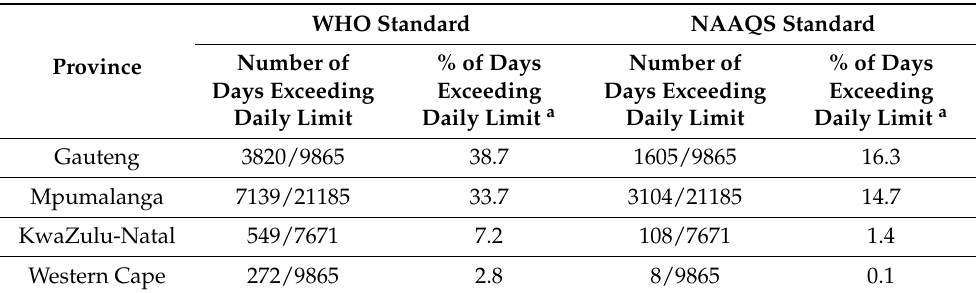
Table 3. The percentage of PM 10 ( µ g/m 3 ) concentration exceeding daily standards by province for the years